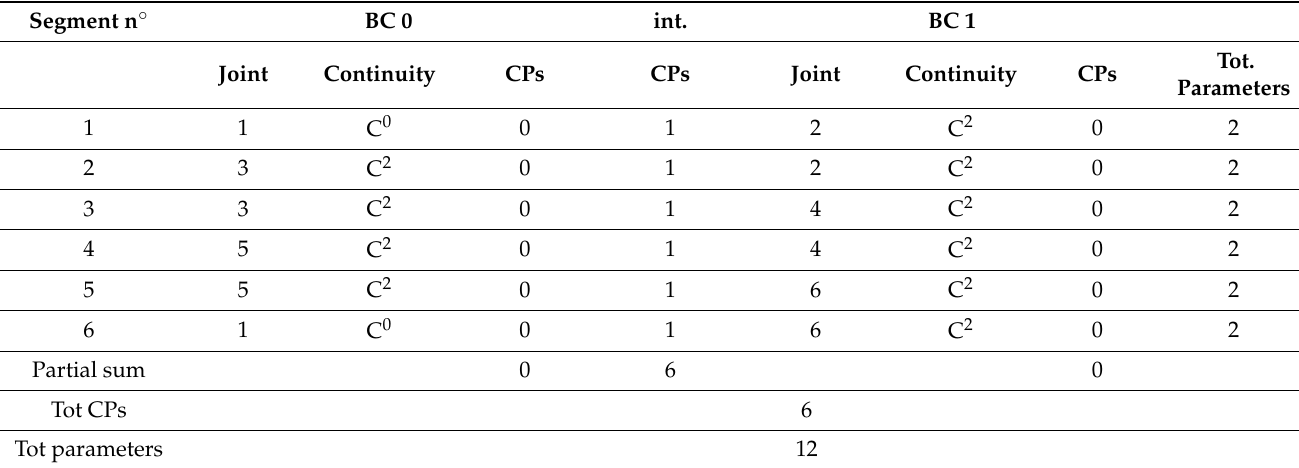
Table 3. Model parameters ensuring C 2 continuity (less model